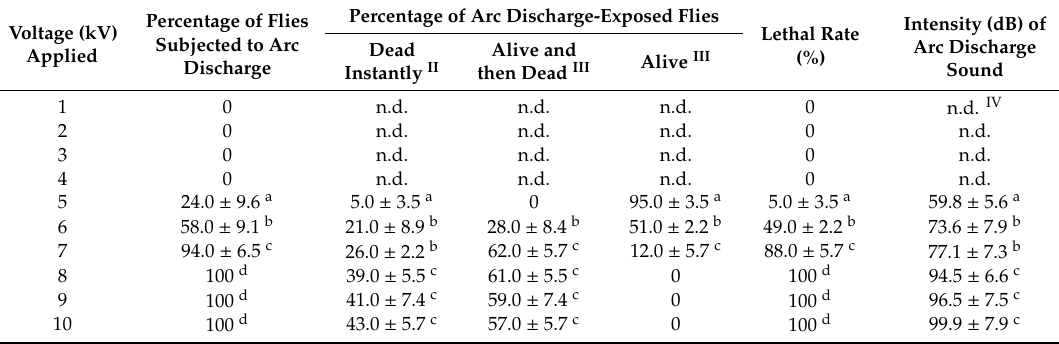
Table 2. Eradication of houseflies by exposure to arc discharge from iron plates negatively charged with di ff erent voltages I